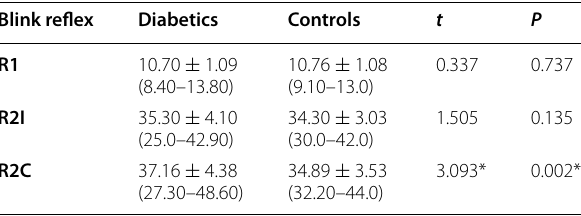
Table 3 Comparison between the diabetic and control groups regarding blink reflex latencies